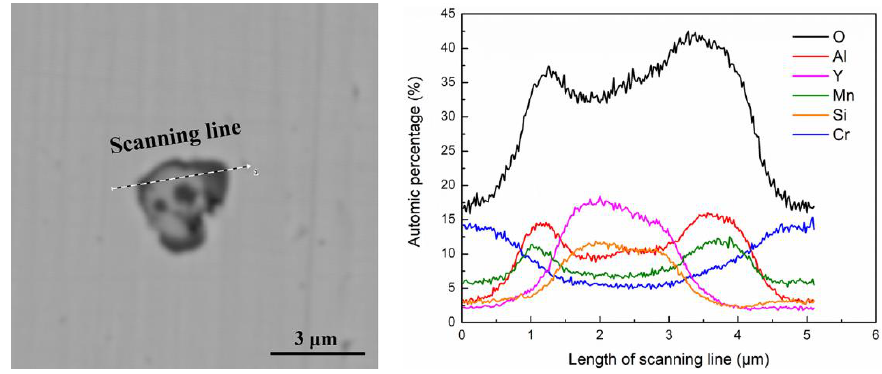
Figure 7. Scanning line analysis of the heterogeneous oxide inclusion.